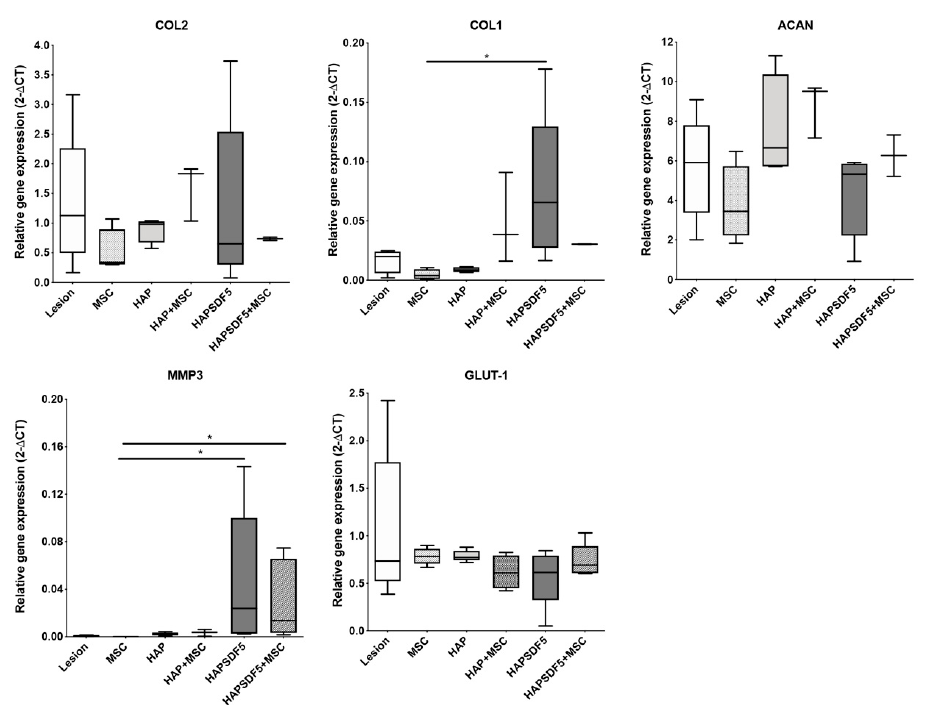
Figure 3. IVD gene expression analysis 2 weeks post-injury and intradiscal administrations. Relative gene expression of the main IVD ECM components: aggrecan (ACAN), collagen type I (COL1), collagen type II (COL2), matrix metalloproteinase MMP3, and oxidative stress marker GLUT-1, normalized to GAPDH. Results are presented as box and whiskers plots (n = 2–5 animals). * p < 0.05.